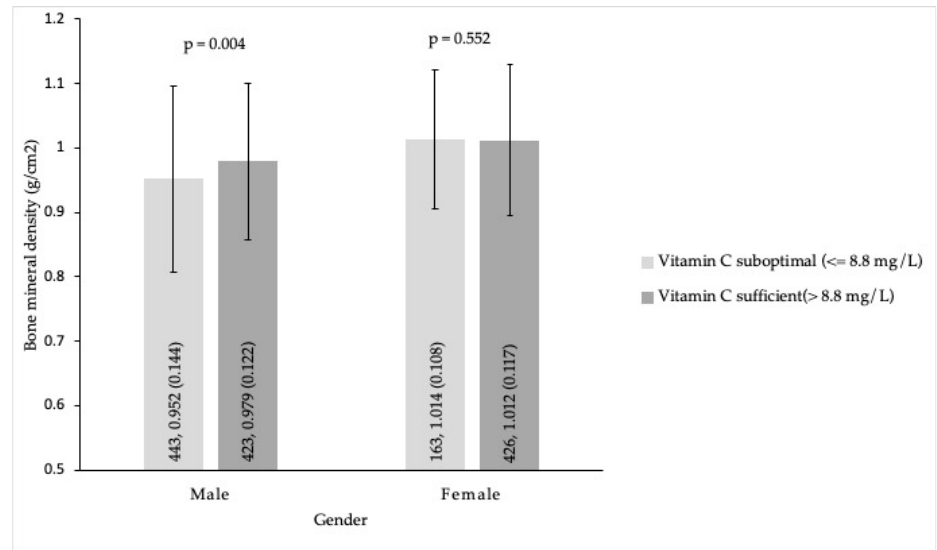
Figure 1. Bone mineral density (g/cm 2 ) (number of cases, mean (standard deviation)) at the lumbar spine across two categories of plasma vitamin C (i.e., suboptimal and sufficient) in men and women. Mann–Whitney U-test was used for the test of the non-normally distributed continuous variables.